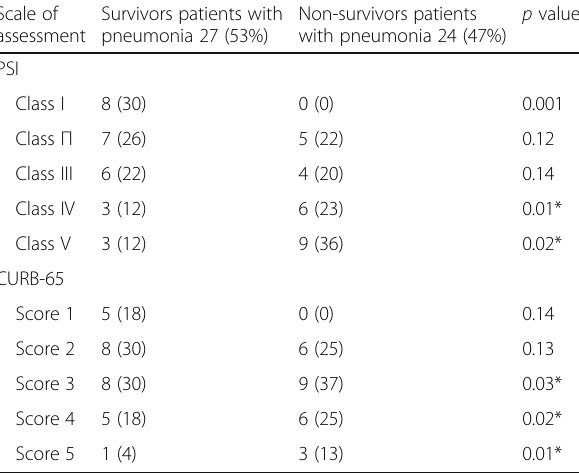
Table 3 Multivariate analysis comparing survivors versus non- survivors of group 1 according to risk factors of 30 day mortality Risk factors of 30-day